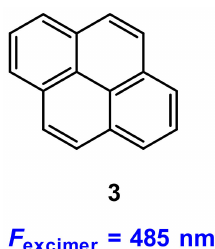
Figure 7. Chemical structure of probe 3